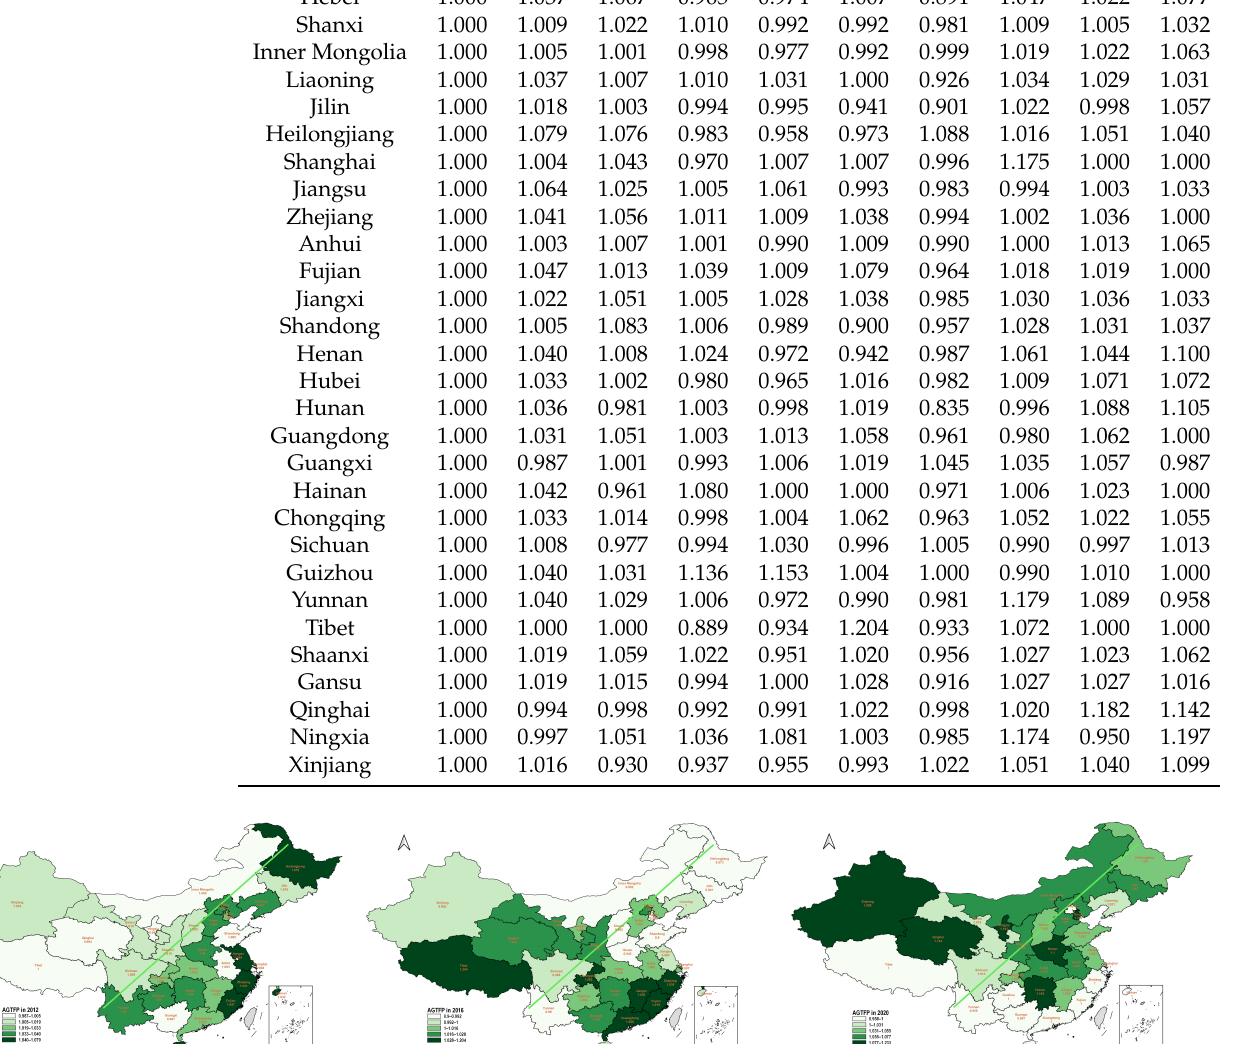
Figure 2. Spatial distribution of China’s AGTFP in 2012, 2016, and